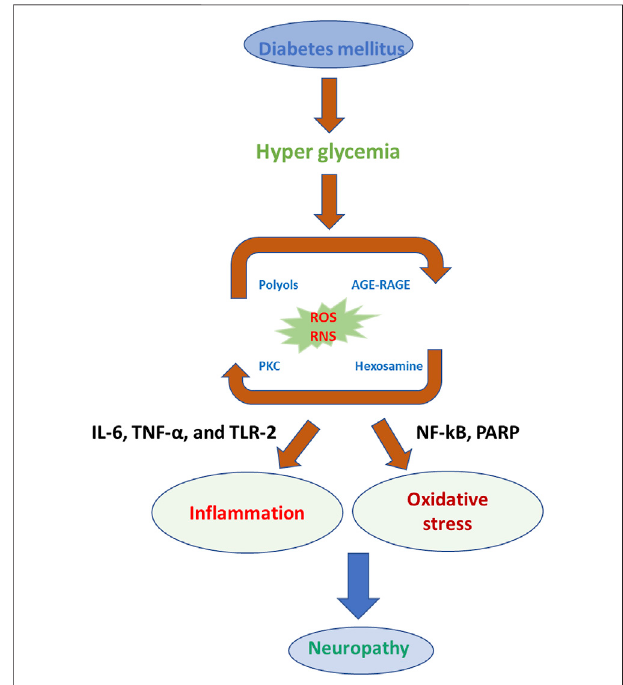
FIGURE 3 | Photographical representation of oxidative stress consequences in the development of neuropathy in DM.